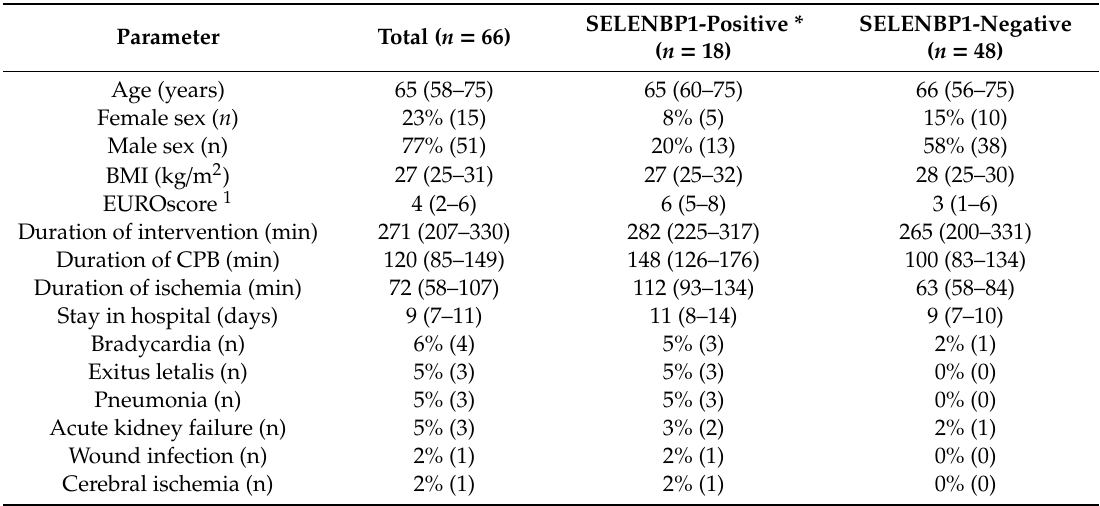
Clinical characteristics of patients in relation to serum selenium-binding protein (1SELENBP1)